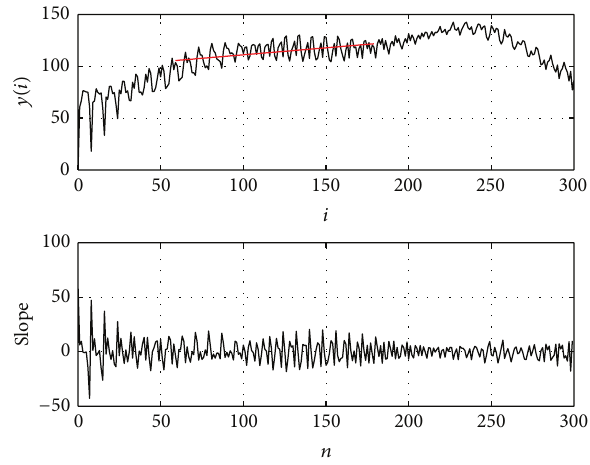
Figure 4: The largest Lyapunov exponent.